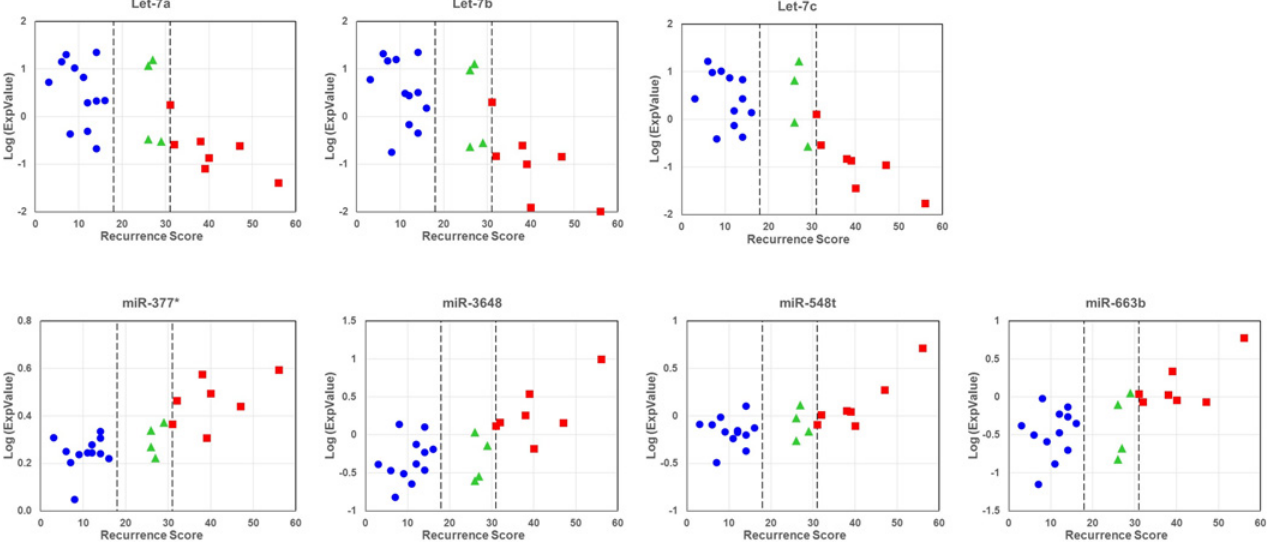
Fig 5. Correlation analysis between miRNA expression level and recurrence score. The relationship between miRNA expression and recurrence score is shown for seven miRNAs with a statistically significant correlation.